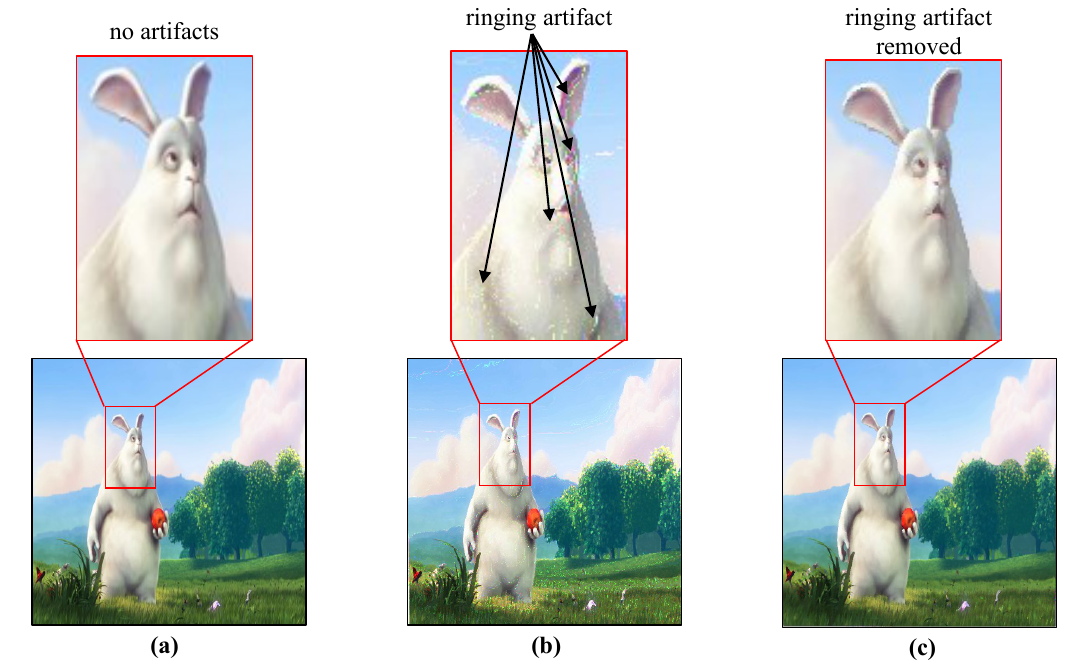
Figure 5. ( a ) original image; ( b ) reconstructed image with pure-binary-code; ( c ) reconstructed image with